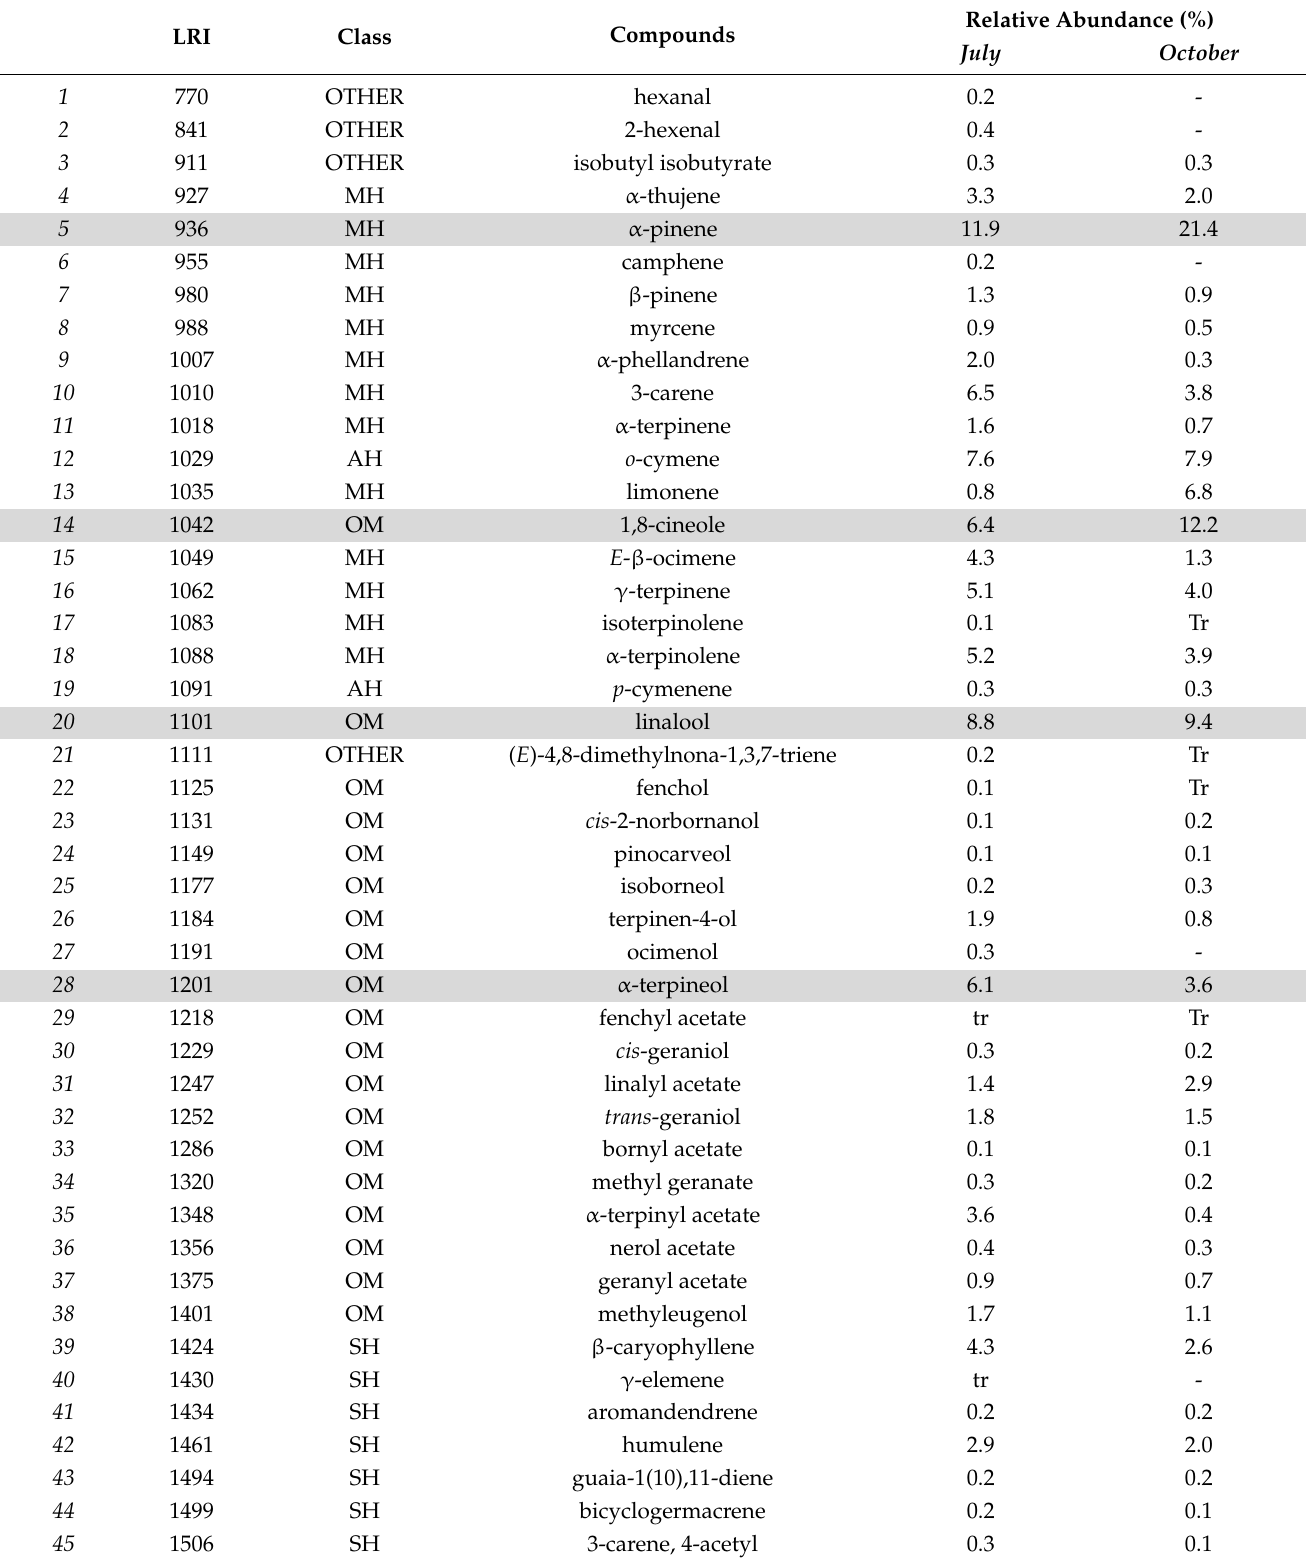
Table 3. GC-MS profiles of the essential oils obtained from the fruits of Myrtus communis subsp. communis collected in July (early fruiting) and in October 2019 (ripening